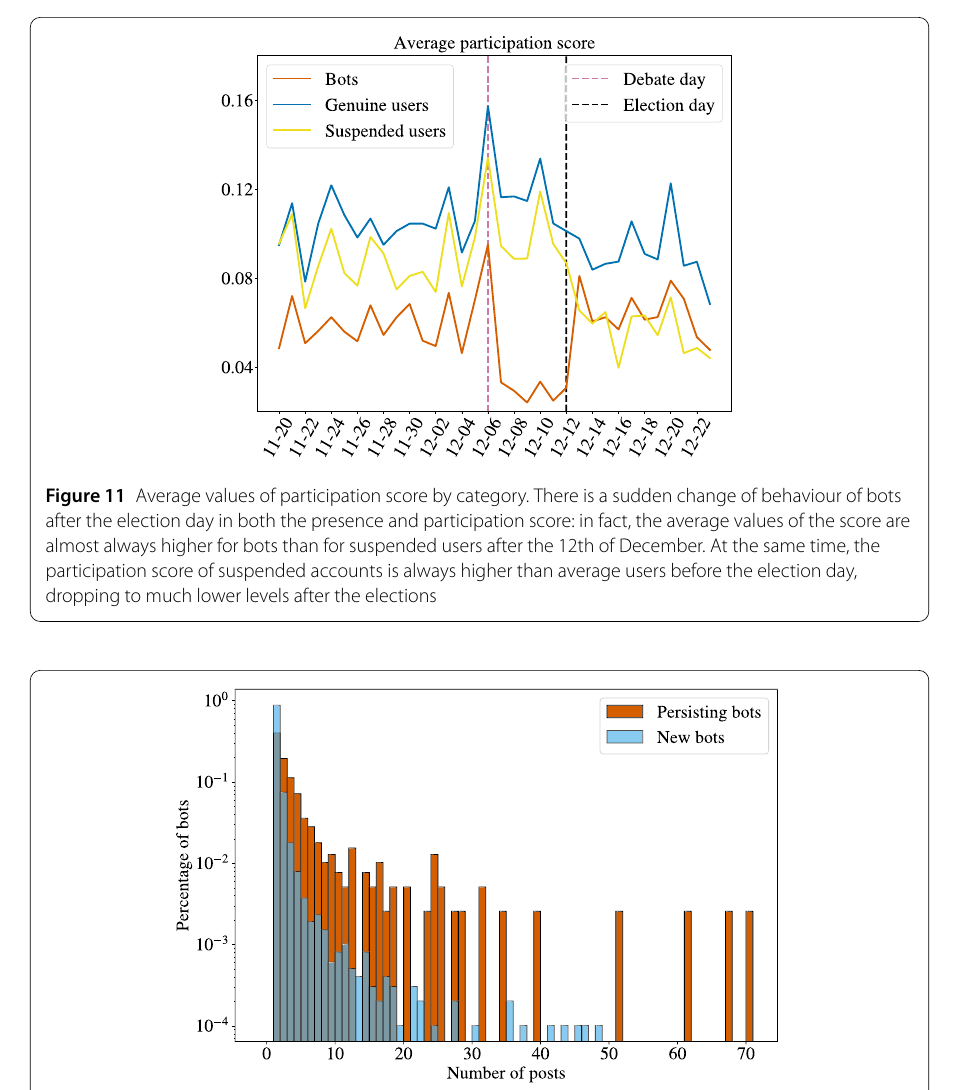
Figure 12 Histogram of the number of posts made by bots. We took bots from the 11th of December, and the two histograms separate the activity of those that were already present in the discussion the 6th of December (persisting bots) from the new entries (new bots). Almost 40% of those of the 6th of December are still in the discussion, and their average activity is almost stable from the two dates. The old users’ activity